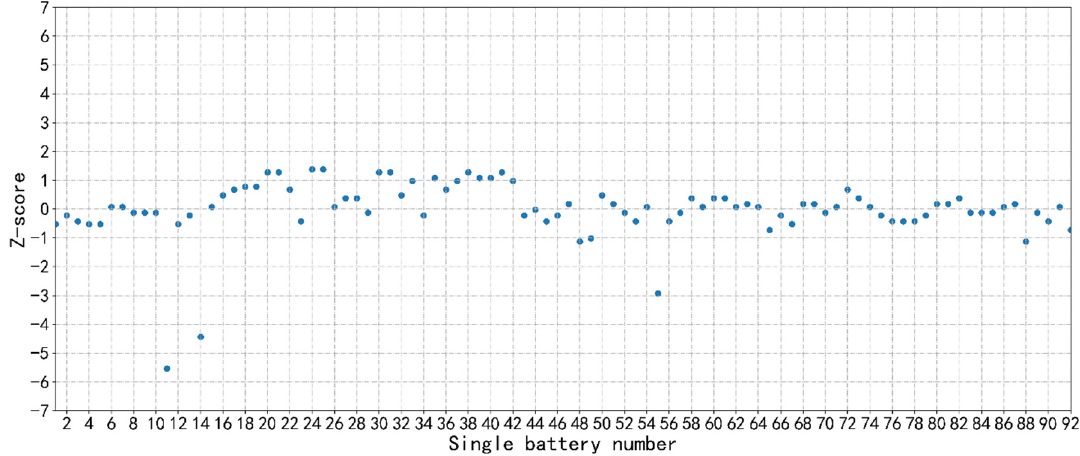
Figure 7. Z-score scatter graph of instantaneous voltage of single cells.